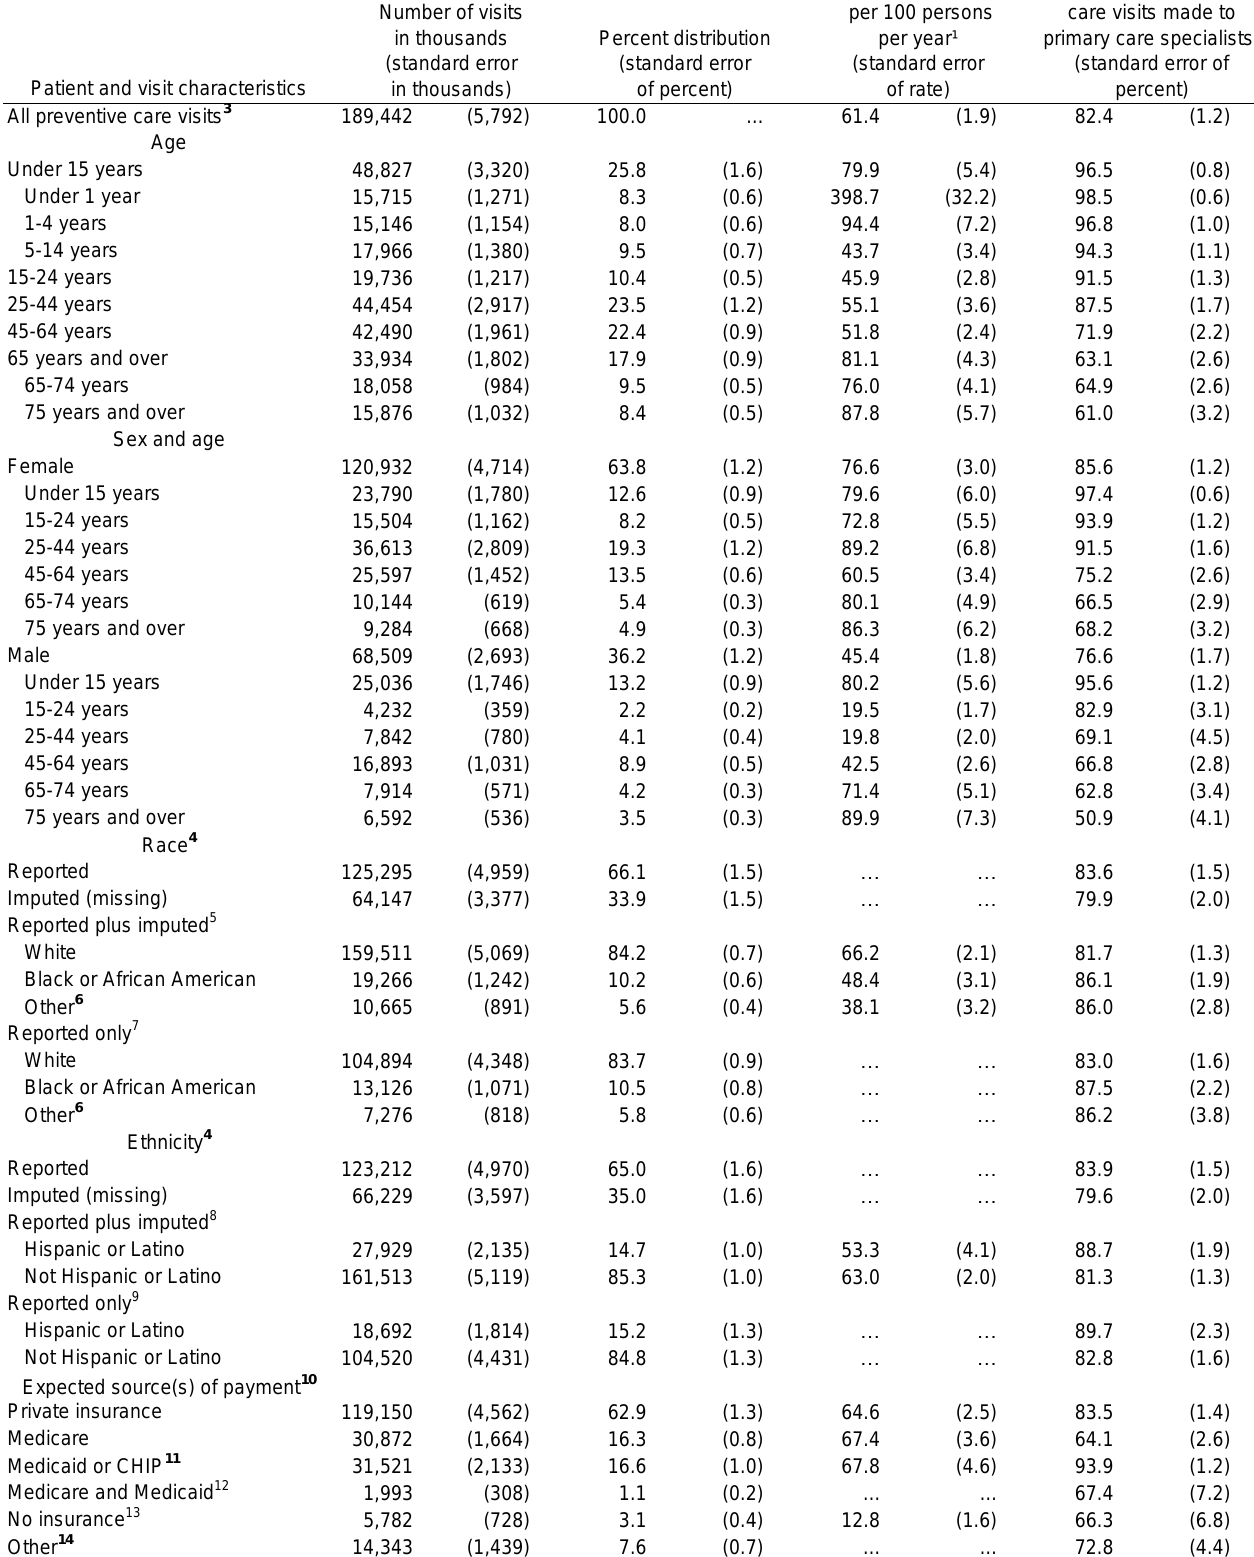
Table 13. Preventive care visits, by selected patient and visit characteristics: United States,